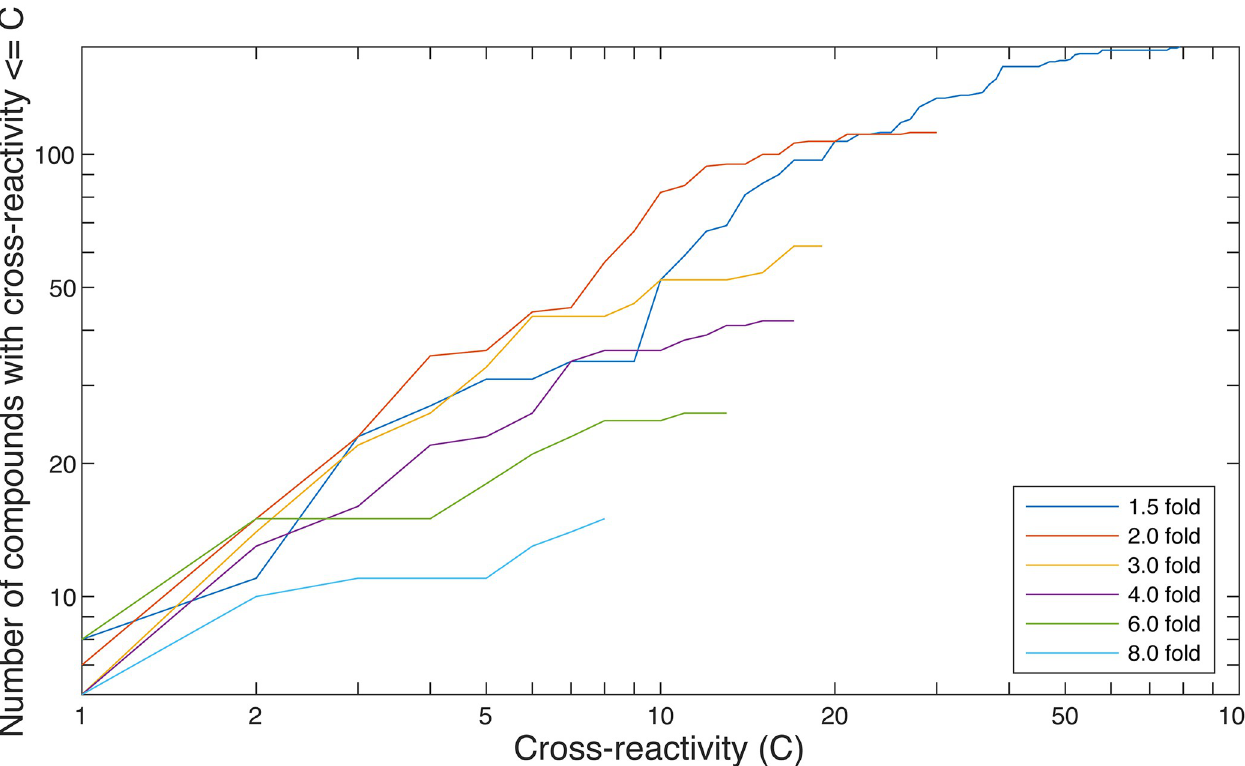
Fig 9. Selective biosensors tend to be more sensitive. At a given fold-change of cleavage, f , the cross-reactivity of a sensor is defined as the number of compounds that induce fold-change of at least f . The cross-reactivity for a compound is then defined as the lowest cross-reactivity of all sensors that respond to the compound with fold-change of at least f . The number of compounds with cross-reactivity less than C is shown as a function of C . For example, at C = 1, the lines indicate the number of compounds that uniquely induce the indicated fold-change in some sensor. As the fold-change of cleavage increases, fewer molecules cross-react, indicating that more sensitive biosensors may be more